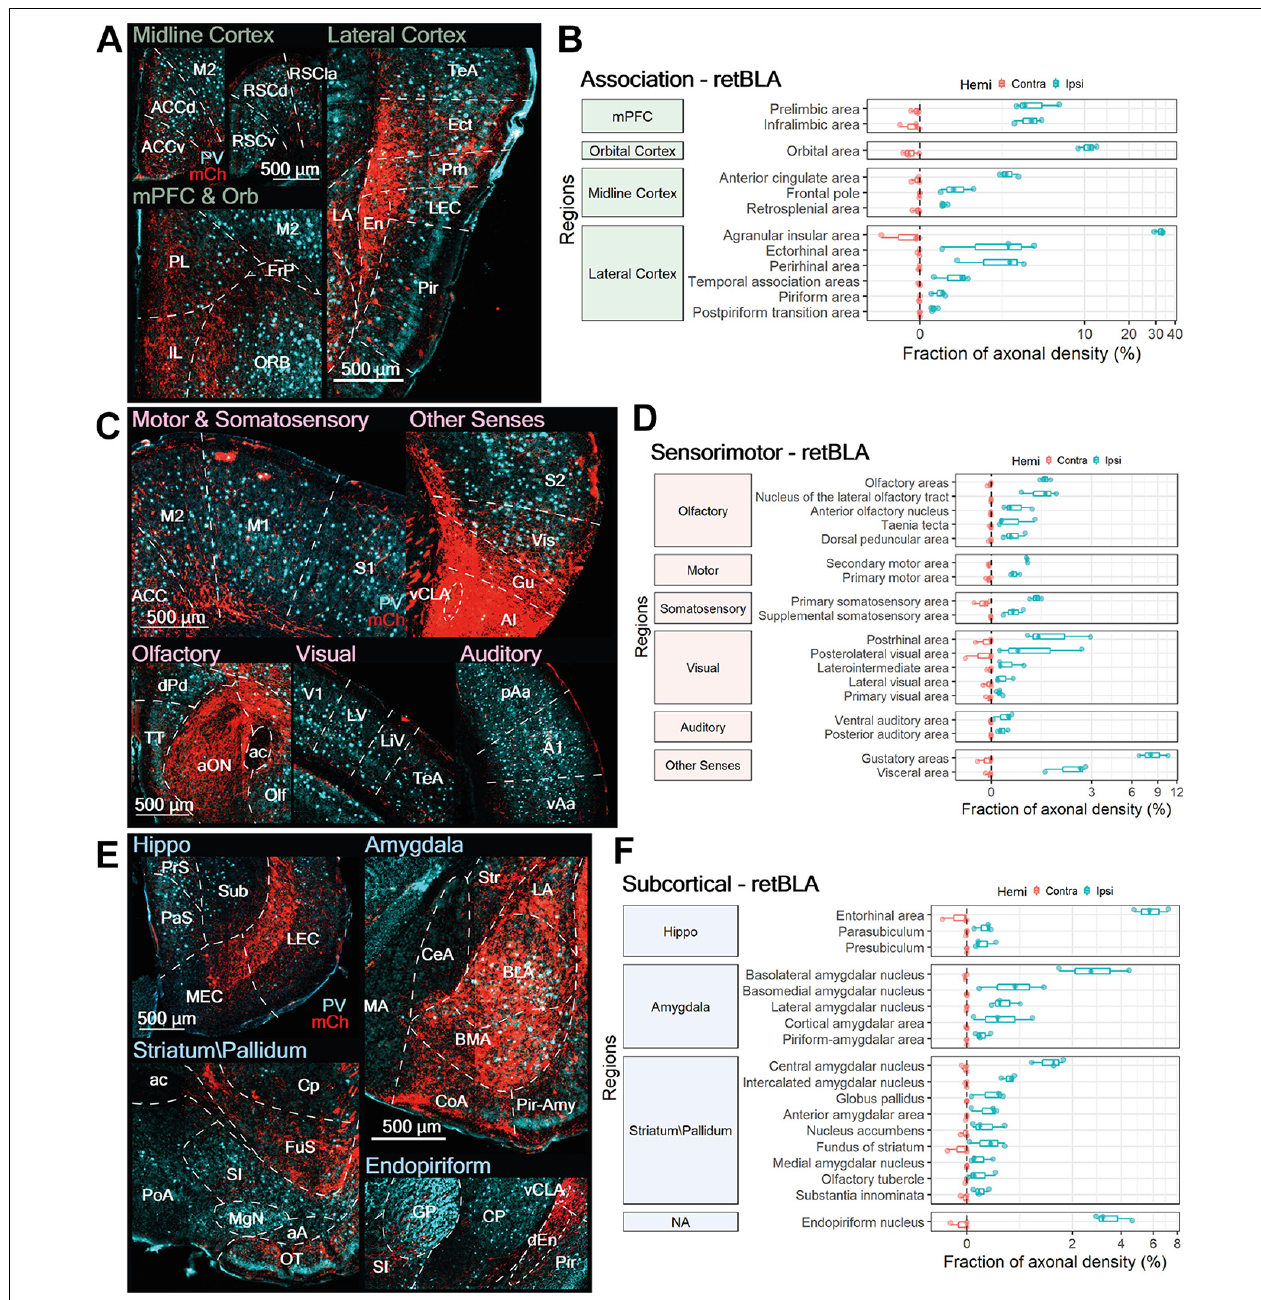
FIGURE 8 | BLA-projecting CLA neurons project to numerous limbic-related sensorimotor, association, and subcortical targets. (A,C,E) Representative images from ipsilateral regions innervated by BLA-projecting CLA neurons: (A) association, (C) sensorimotor, and (E) subcortical. mCherry labeled axon fibers in red (mCh) and PV expression in cyan. (B,D,F) Quantification of regions innervated by BLA-projecting CLA neurons in the contralateral (red) and ipsilateral (blue) hemispheres for (B) association, (D) sensorimotor, and (F) subcortical. Axon density from each region is represented as a fraction of whole brain axon density; note logarithmic scale. Region abbreviations: ACC, ACCd, Anterior cingulate cortex, dorsal; M2, M1, Secondary, primary motor cortex; RSCv, RSCd, RSCla, Retrosplenial cortex ventral, dorsal, lateral; PL, Prelimbic cortex; IL, Infralimbic cortex; FrP, Frontal Pole; ORB, Orbital area; dEn, En, dorsal, Endopiriform nucleus; TeA, Temporal association area; Ect, Ectorhinal cortex; Prh, Perirhinal cortex; Pir, Piriform cortex; S1, S2, Primary, secondary somatosensory cortex; Vis, Visceral area; Gu, Gustatory area; AI, Agranular Insula; vCLA, ventral claustrum; TT, Taenia tecta; dPd, Dorsal peduncular area; aON, Anterior olfactory nucleus; ac, anterior commissure; Olf, Olfactory area; V1, Primary visual cortex; LV, Lateral visual area; LiV, Laterointermediate area; pAa, vAa, A1, Posterior, ventral, primary auditory area; PrS, Presubiculum; PaS, Parasubiculum; Sub, Subiculum; LEC, MEC, Lateral, medial entorhinal cortex; Str, Striatum; MA, CeA, LA, BLA, BMA, Medial, central, lateral, basolateral, basomedial amygdala nucleus; CoA, Pir-Amy, Cortical, Piriform- amygdala area; Cp, Caudate putamen; FuS, Fundus of striatum; SI, Substantia inominata; PoA, Posterior amygdala nucleus; MgN, Magnocellular nucleus; aA, anterior amygdala area; OT, Olfactory tubercle; GP, Globus pallidus.